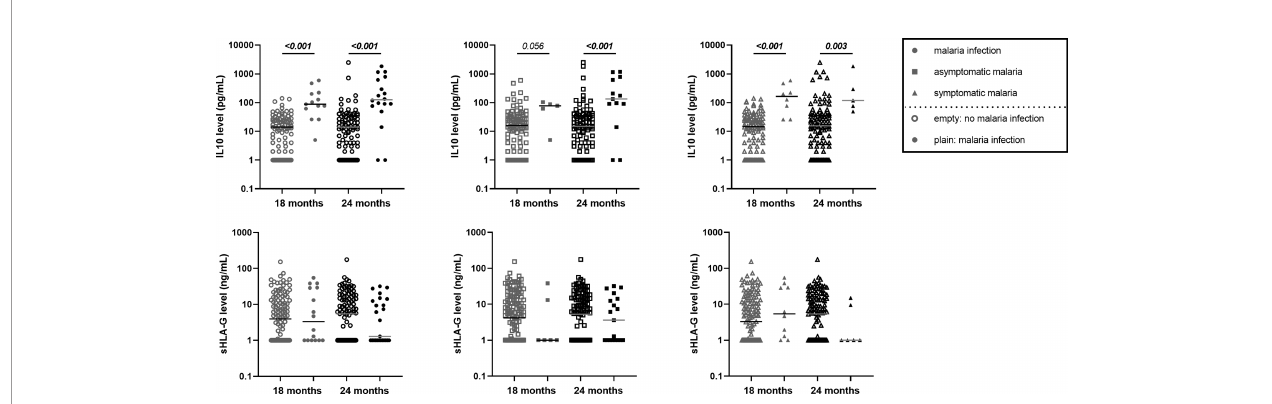
FIGURE 6 | Higher IL10 level in infants with either symptomatic or asymptomatic malaria infection. The level of IL10 in pg/mL from the plasma of infant at 18 and 24 months of age was represented on the fi rst row of graphics. HLA-G level in ng/mL from the plasma of infant at 18 and 24 months of age was represented on the second row of the graphics. Empty circle, square and triangle (gray or black) represented infants without malaria infection at the time of sample collection. Plain circle, square and triangle (gray or black) represented infant with malaria infection, symptomatic malaria and asymptomatic infection, respectively. The horizontal dark line in the beeswarm plot represents the median value. P-values in bold were the one that were still considered signi fi cant after Bonferroni